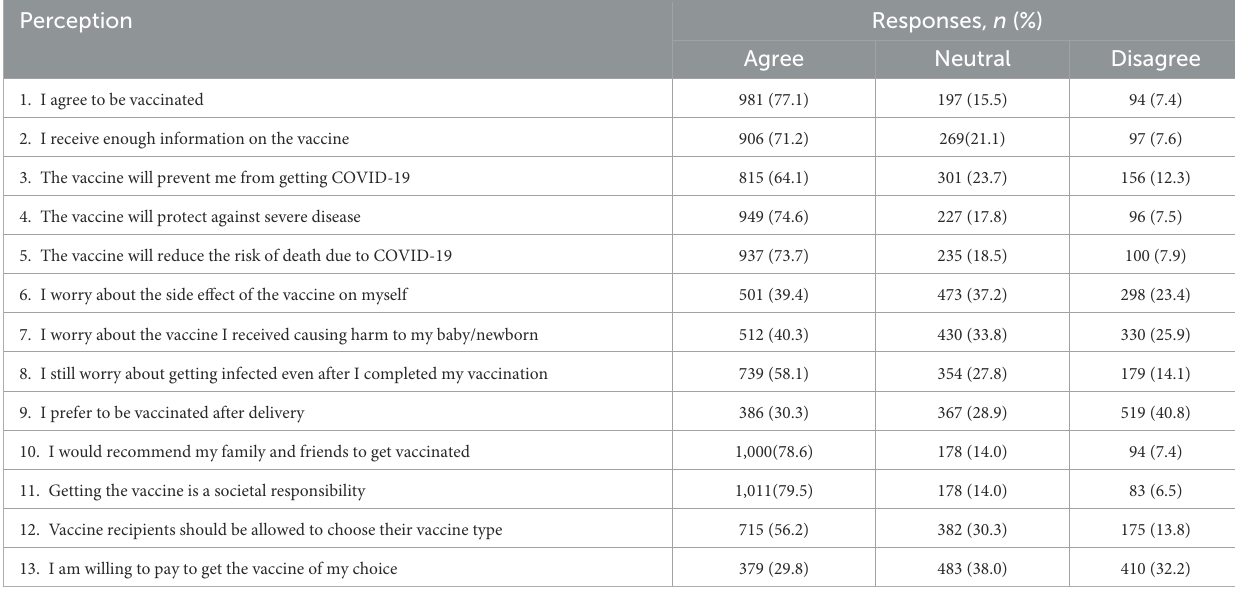
TABLE 3 Maternal COVID-19 vaccine perceptions and attitudes.